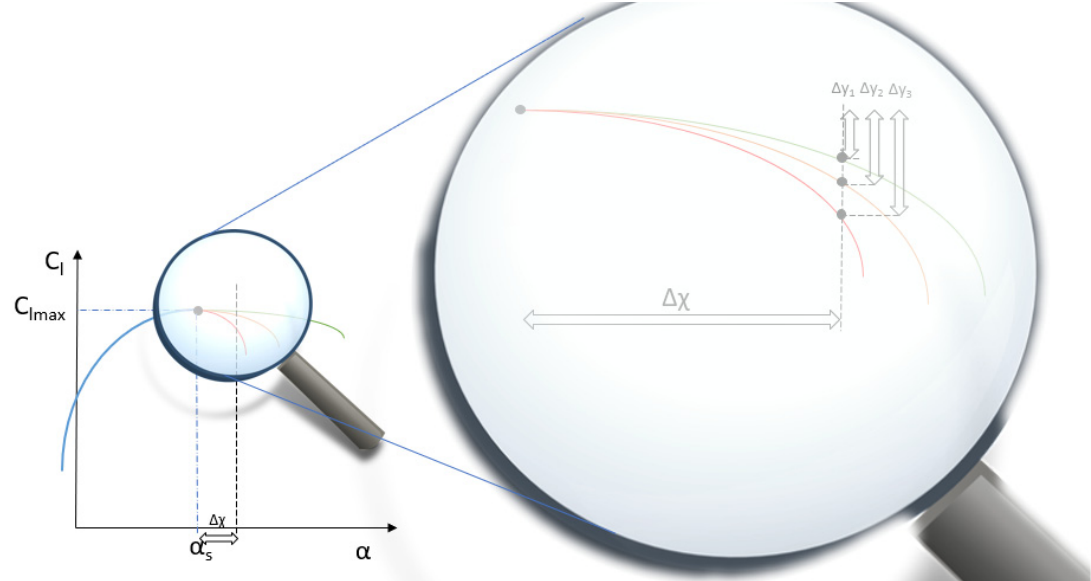
Figure 7. A way to quantify the stall quality. Figure 7 represents an ideal C l - α diagram. Left part contains α s and C lmax points. Further to the right than the critical a s point, three hypothetical stall curves are displayed. Obviously, the preference is green > orange > red. We consider a vertical line at distance Δ x from the α s